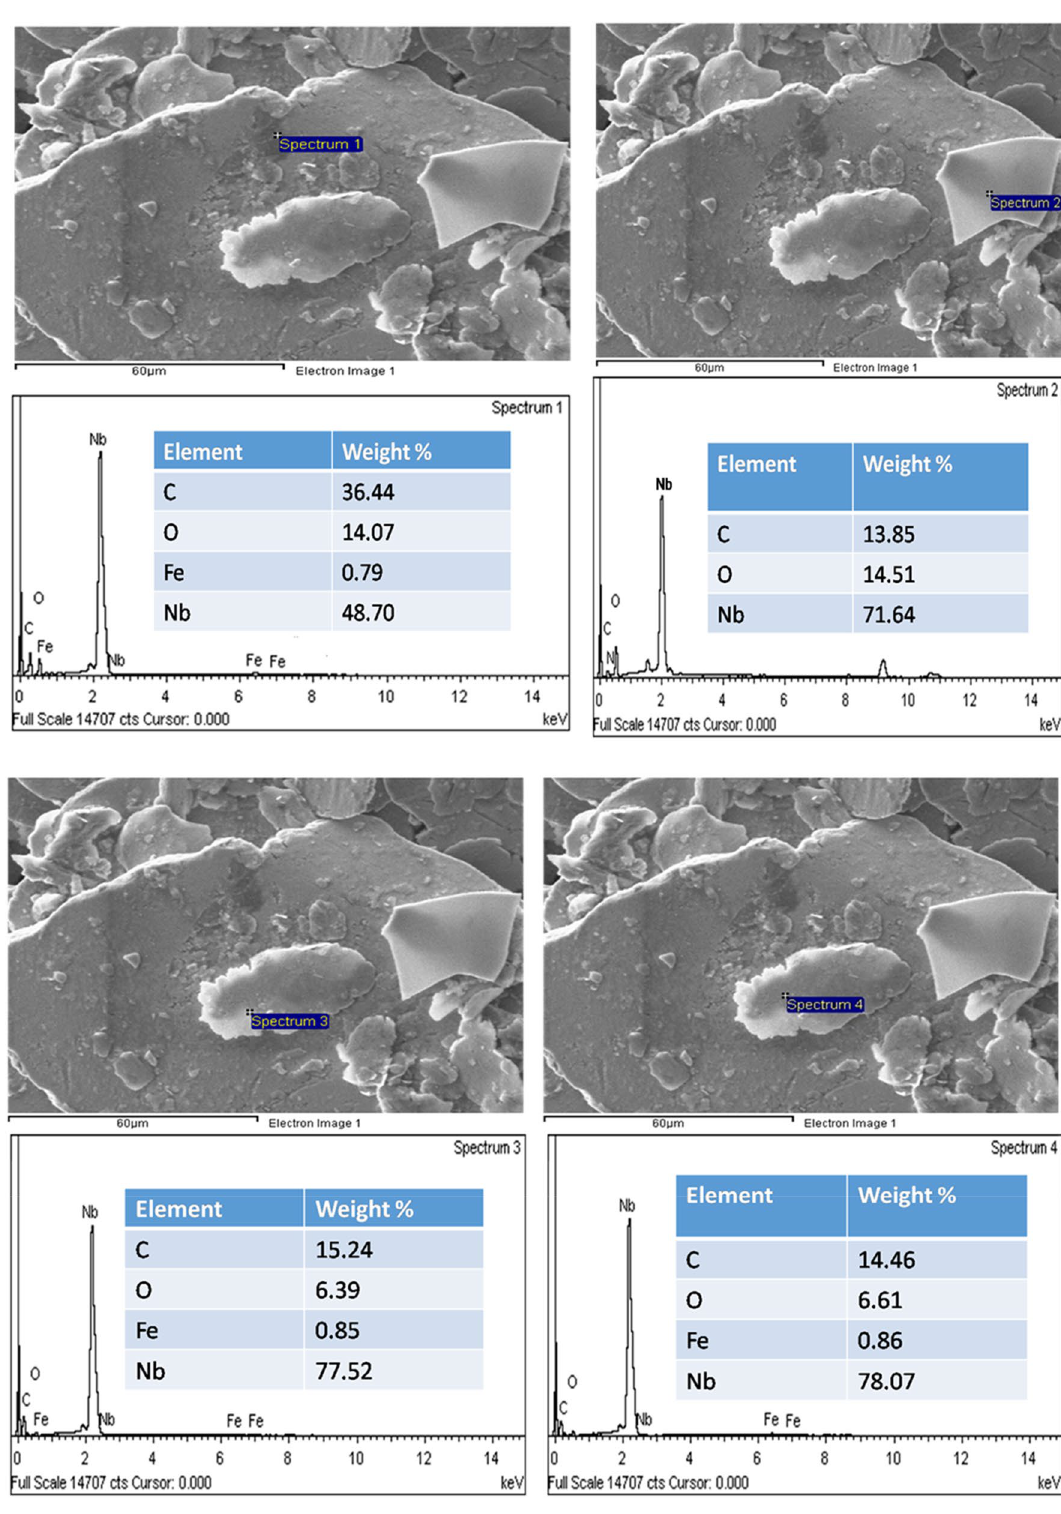
Figure 7. EDS element composition of the milled Nb